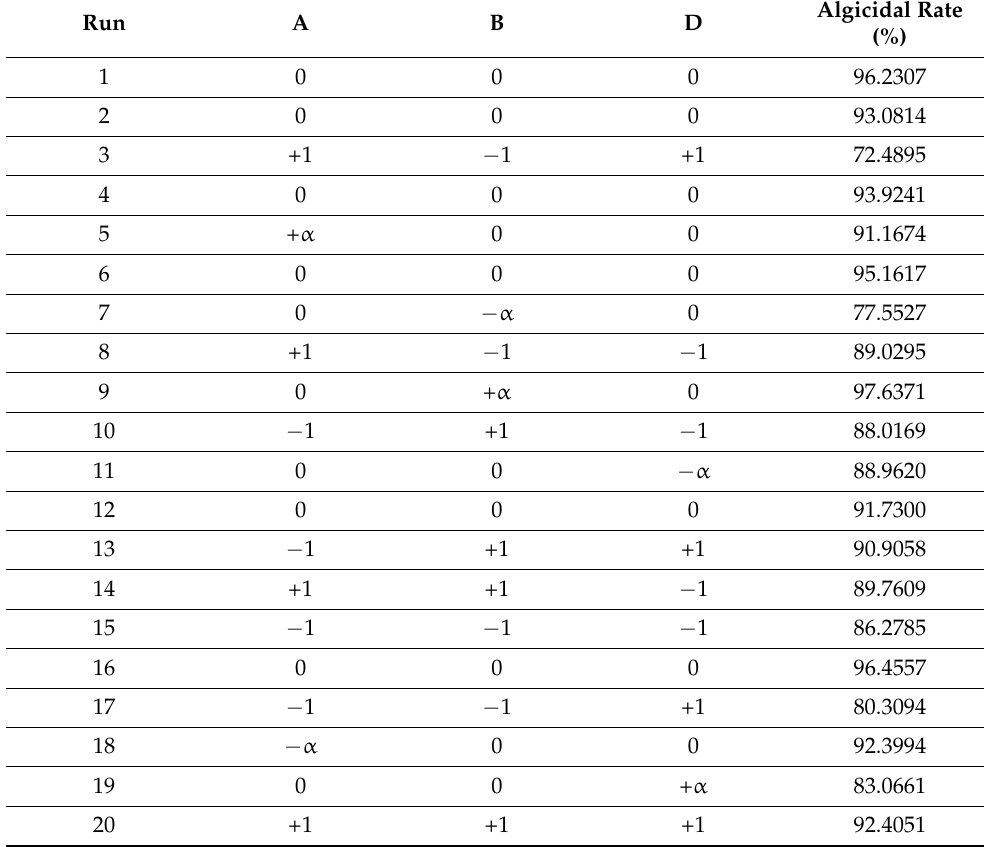
Table 4. Twenty-runs central composite design matrix of three variables and algicidal rate of strain